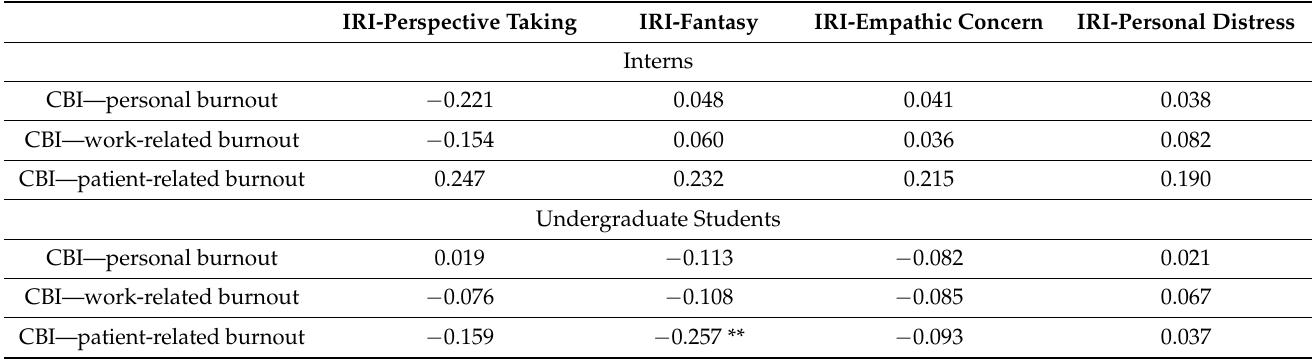
Table 3. Correlation of social cognitive function with burnout scores among interns and undergradu- ate